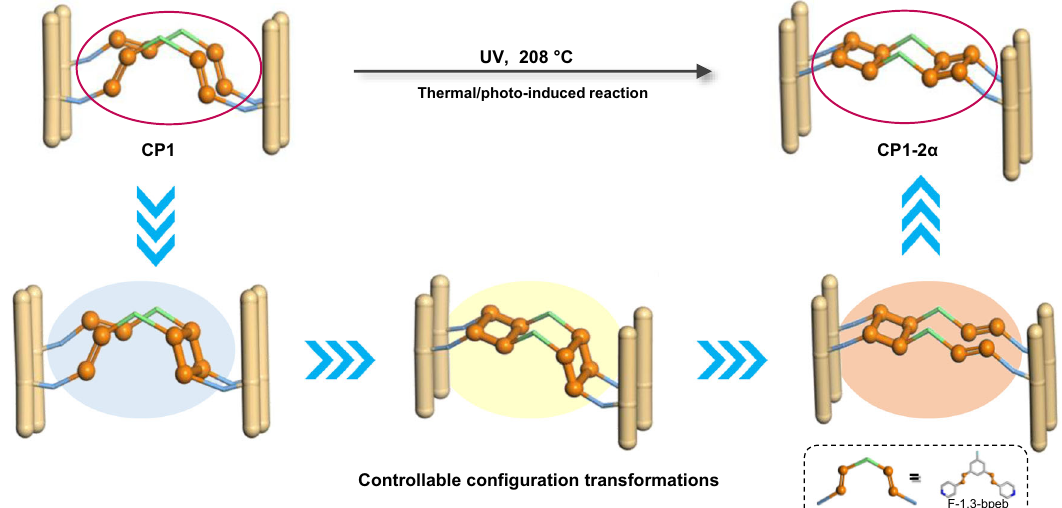
Fig. 1 Schematic illustration. The controllable multiple-step con fi guration transformations of CP1 to CP1 - 2 α by adjusting the reaction temperatures, which require going through four steps and three isomeric intermediates. Color codes: N, blue; F, sky blue; O, red; C, gray. Hydrogen atoms are omitted for clarity. All the con fi gurations and transformations of C = C groups associated with the above reactions are highlighted in orange.